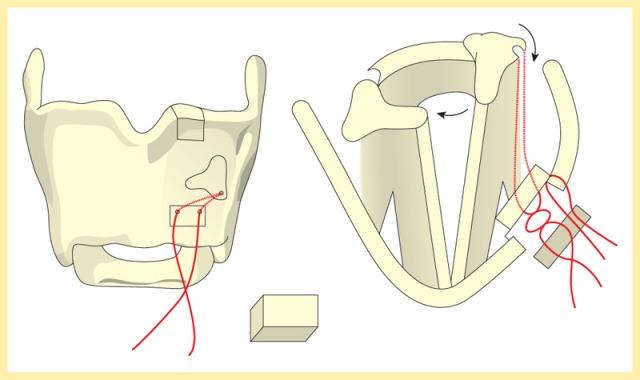
Thyroplasty type I with arytenoid adduction with cartilage